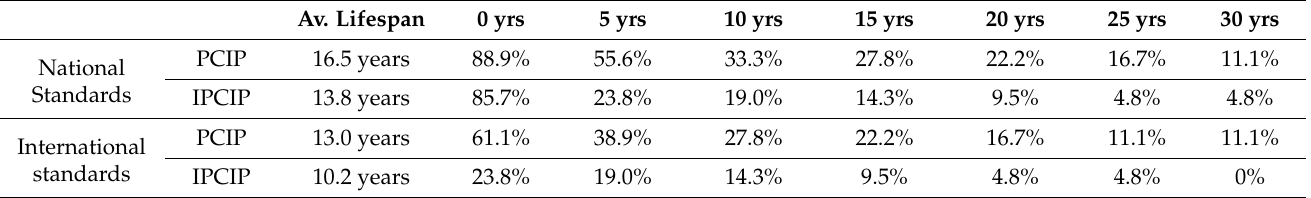
Table 1. Application of the observed time effects on the infiltration rate of infiltrating pavements in relation to the national guidelines and international standards and percentage of systems (%) func- tioning according to (inter)national standards in years after the moment of measurement.